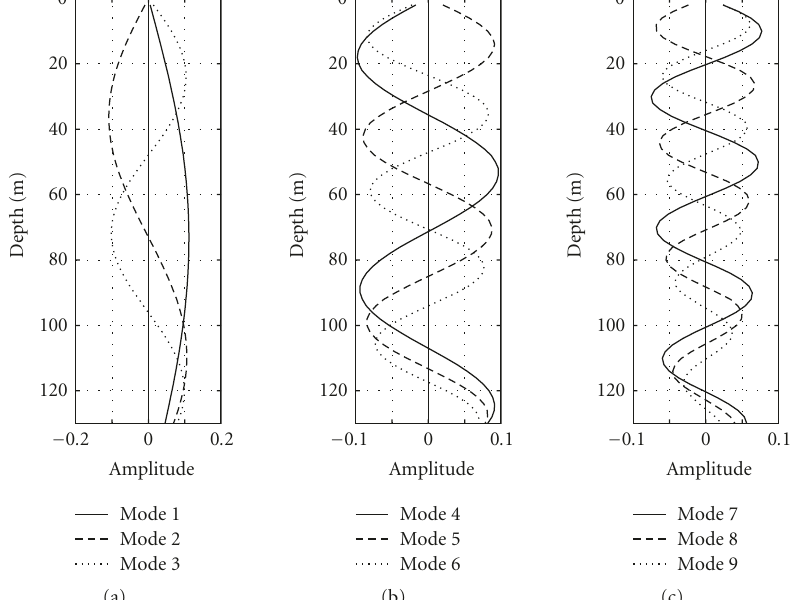
Figure 3: Theoretical modal functions no. 1 to 9 based on Moctesuma’ s modelization. The frequency-dependent functions are calculated as a mean over frequency band 1 to 100